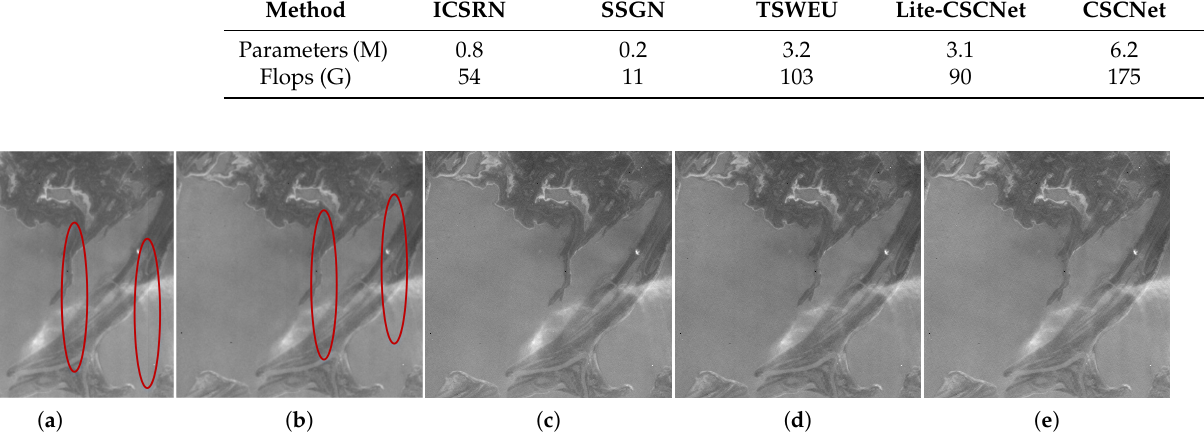
Figure 20. Corrected CHRIS_AM images for band 1. ( a ) ICSRN, ( b ) SSGN, ( c ) TSWEU, ( d ) Lite- CSCNet, ( e ) CSCNet.